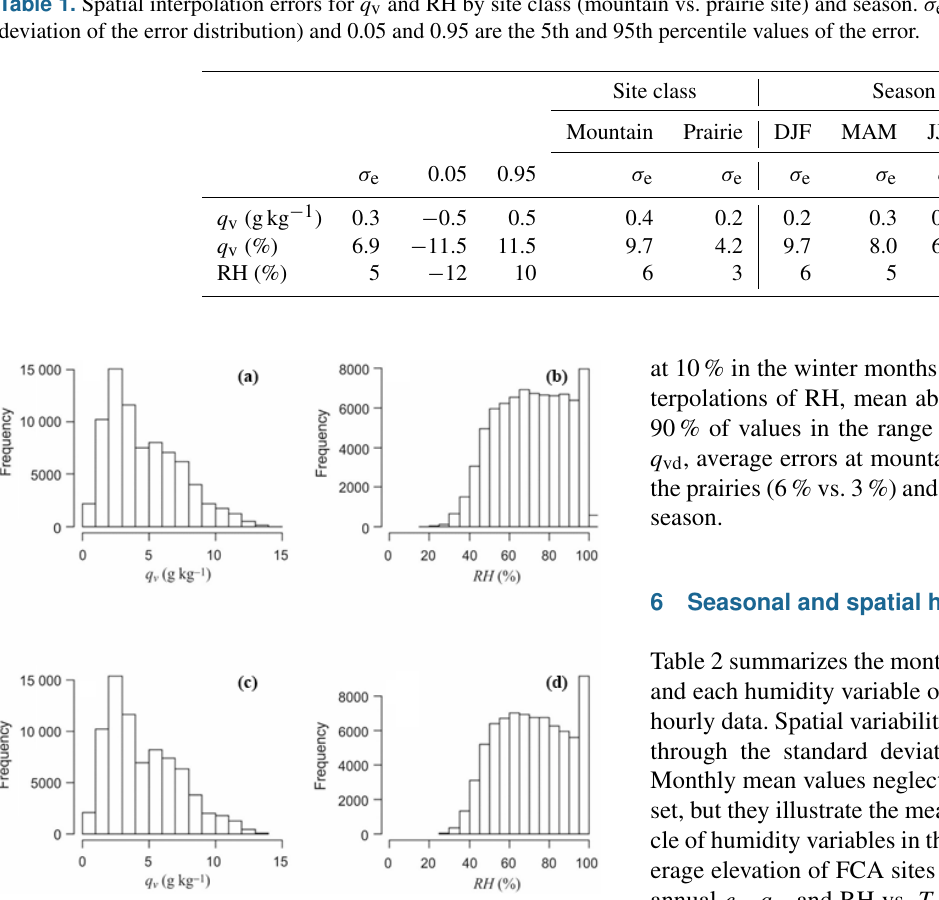
Figure 3. Frequency distributions of (a, b) actual and (c, d) inter- polated specific and relative humidity. Interpolated values are cal- culated from the optimized IDW model applied to all sites in the cross-validation (leave-one-out)